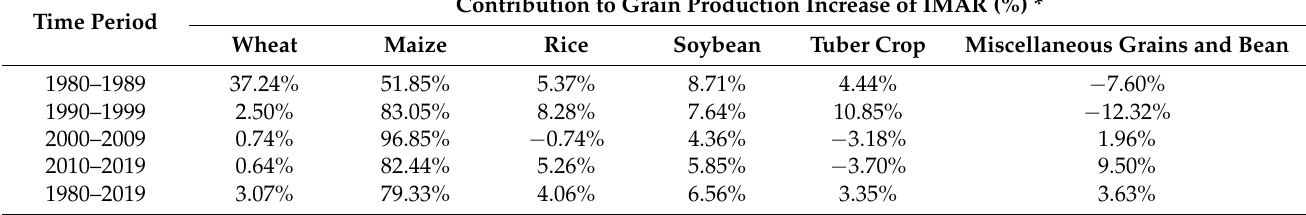
Table 2. Contributing factors and contribution rates of increases in grain production during selected periods in Inner Mongolia Autonomous Region.